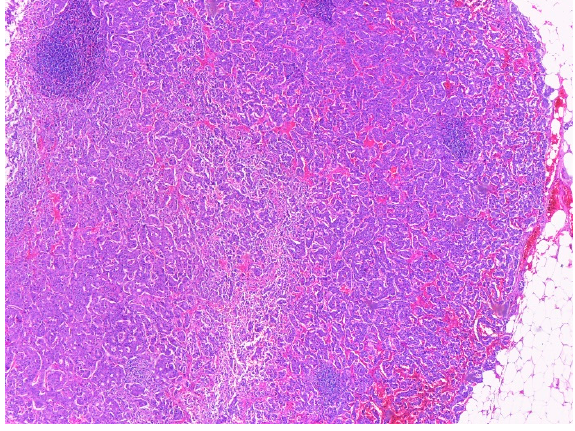
Figure 9. NEN infiltrating the pancreas (normal acini are seen in the lower left corner) in Hematox ‐ ylin and eosin stain, ×100: ( A ) NEN infiltrating the pancreas (P); Nests of tumor cells with bland nuclei without nucleoli. Immunohistochemical staining for Cromogranin A, ×400 ( B ).